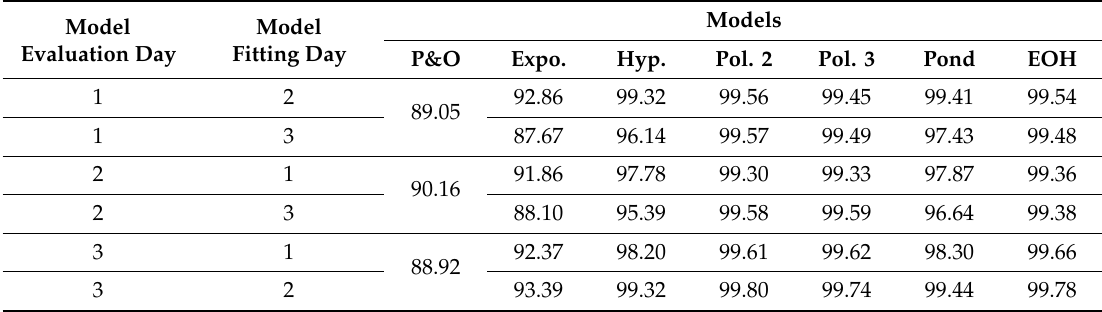
Table 4. Obtained performances (percentage of tracking efficiency) with variable load.